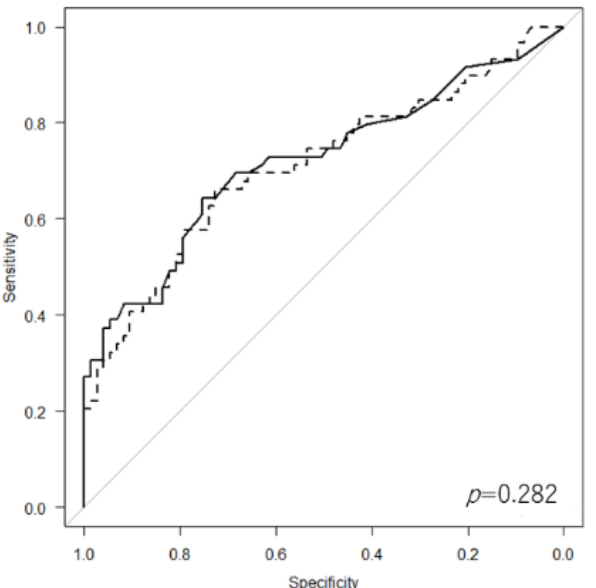
Figure 4. Receiver operating characteristic curve showing no significant difference in area under the curve between C-reactive protein level (solid line) and lymphocyte-to-C-reactive protein ratio (dotted line).